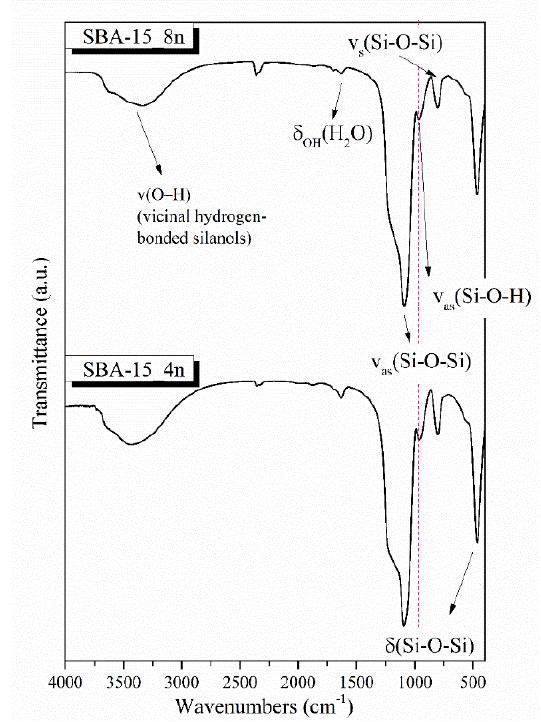
Figure 4. FTIR spectra of the synthesized SBA ‐ 15